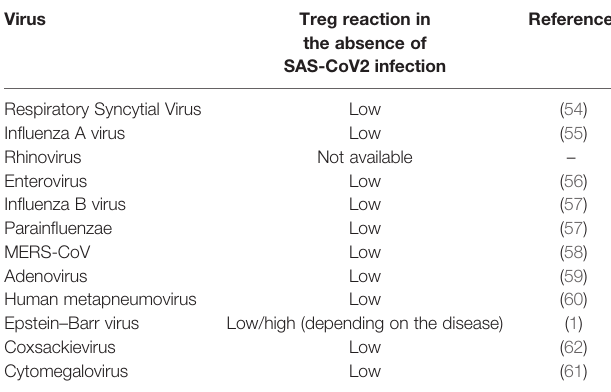
TABLE 3 | Viral coinfections in COVID-19 patients (in a descending order of their prevalence) (45) and Treg reaction to the viruses in the absence of